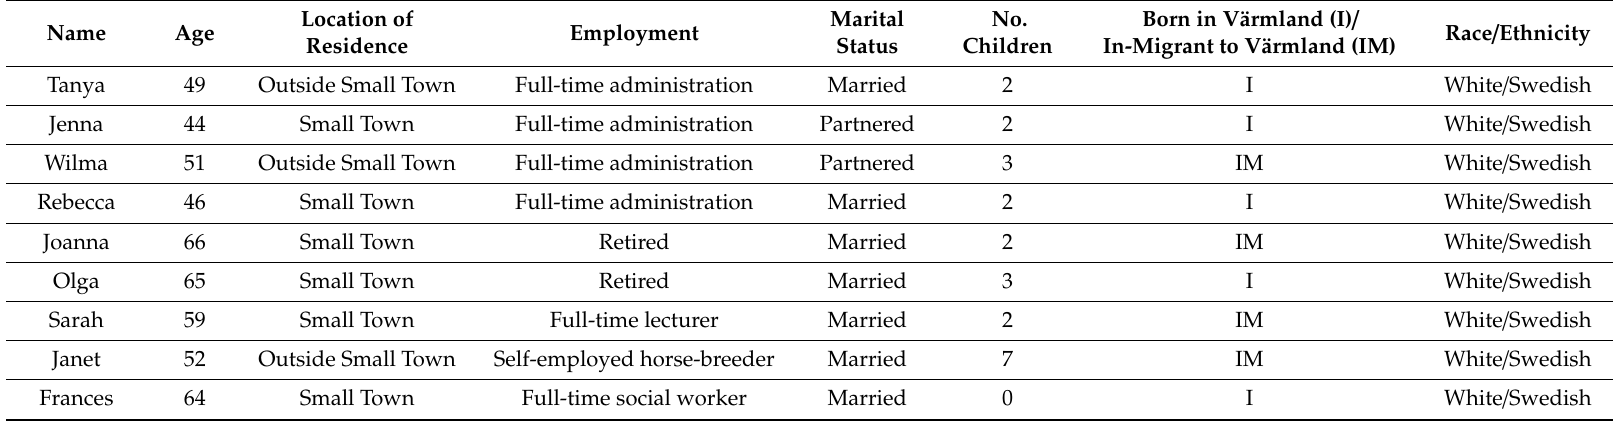
Table A2. Demographic table Sweden